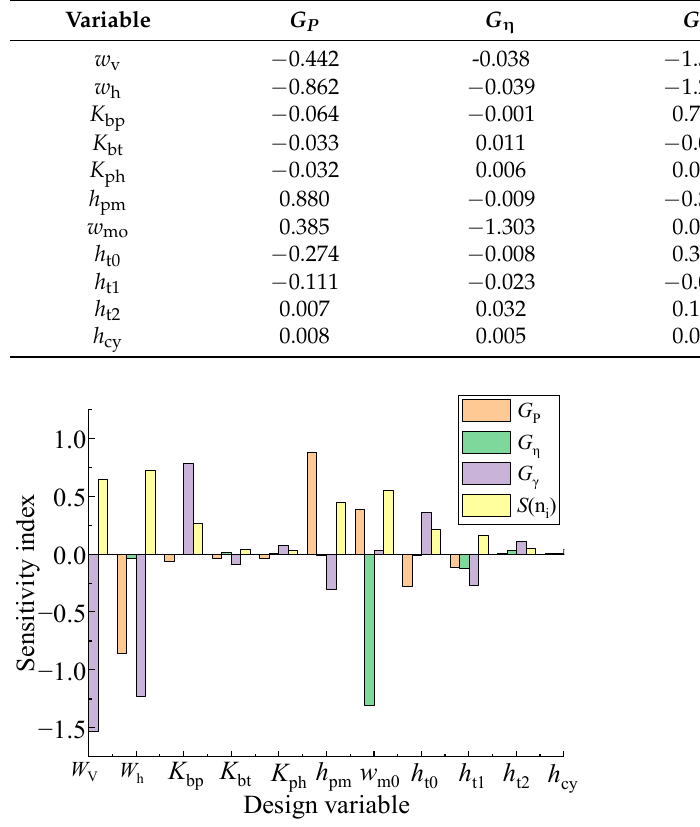
Figure 11. Sensitivity index of design variables. Table 4. Sensitivity values of three design variables.